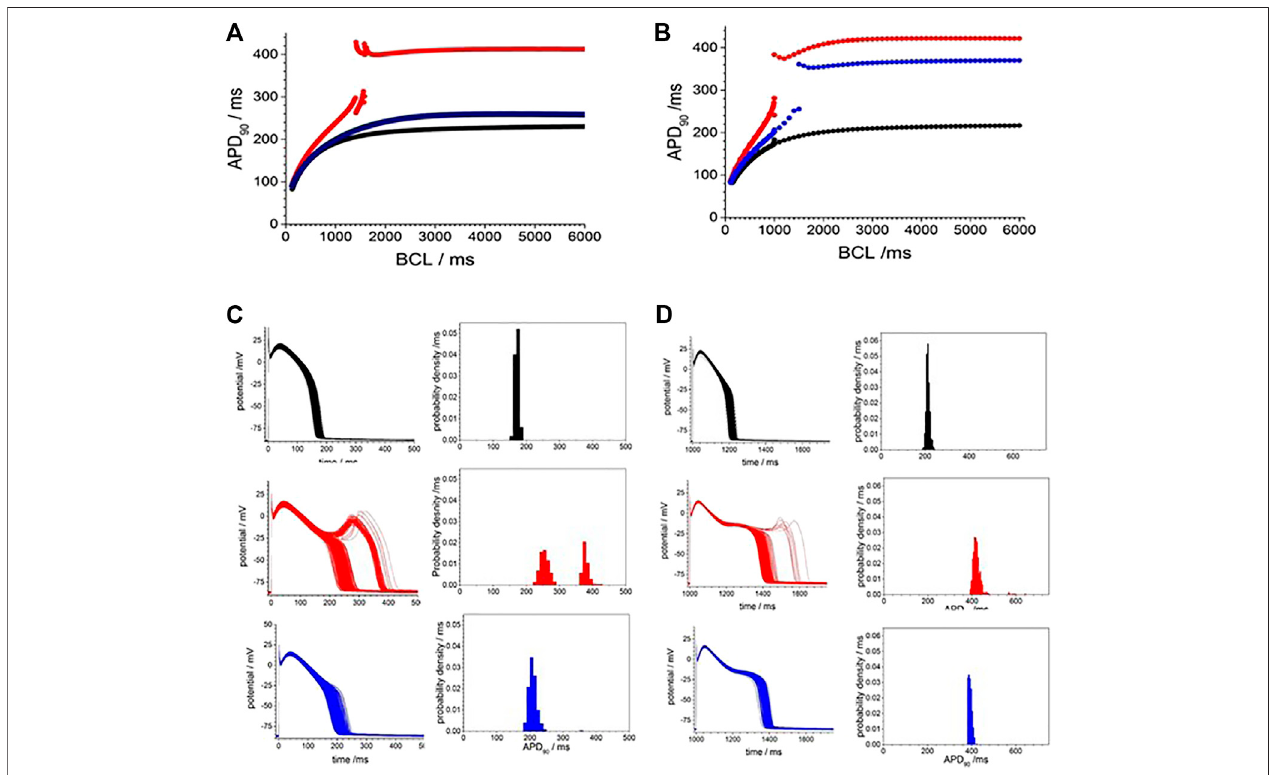
FIGURE 5 | Action potential prolongation in Luo-Rudy dynamic model (LRd) by the effects of CO is reduced by the hERG modi fi er NS1643. Dynamic restitution curvesfor (A) endo-and (B) epi-cardialmodelswithstandardvalues(black).ormodi fi edfortheeffectsofCO(red),ortheeffectsofCOandNS1643(blue).100thperiodic triggeredactionpotentials,andtheirAPD 90 histograms,atBCLof6sforpopulationof (C) endo-and (D) epi-cardialcellmodelswithallthecurrentmagnitudeparameters Gaussiandistributedwitha5%standarddeviation,andthemeansoftheseparameterseithertheirstandardvalues(black),ormodi fi edfortheeffectsofCO(red),or the effects of CO and NS1643